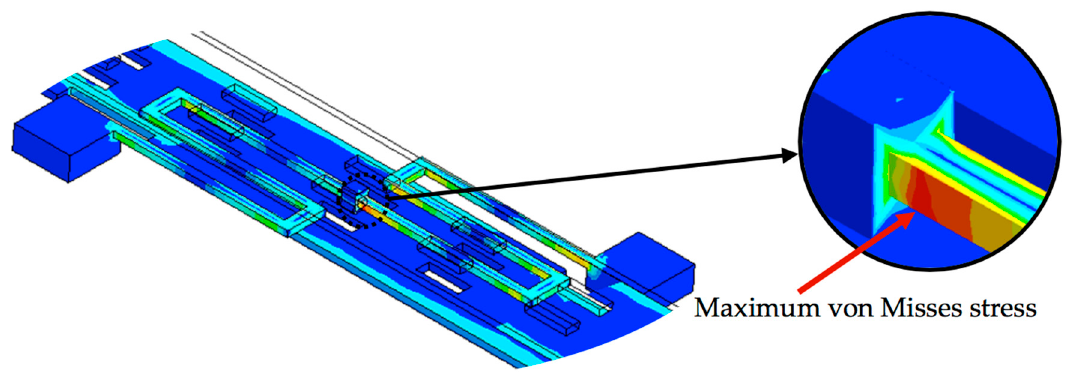
Figure 14. Maximum von Misses stress on the serpentine springs of the microgripper.